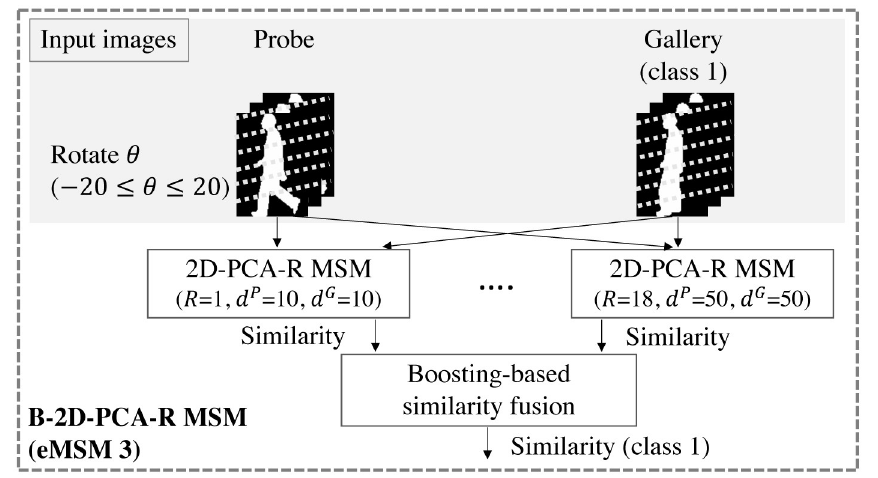
Fig 11. Overview of B-2D-PCA-R MSM. The output similarity is used in the classification process in Fig 5.